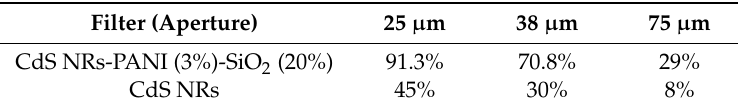
Table 1. Pore retention of different materials.